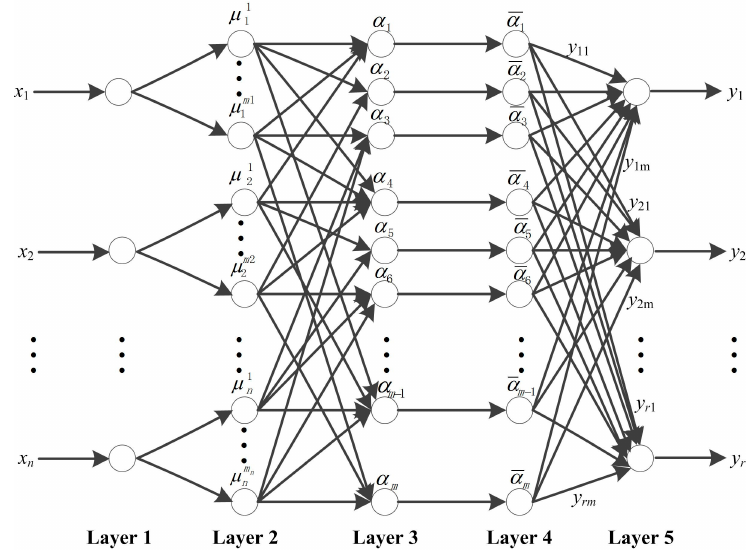
Figure 2. The architecture of Neuro-Fuzzy Network (NFN).